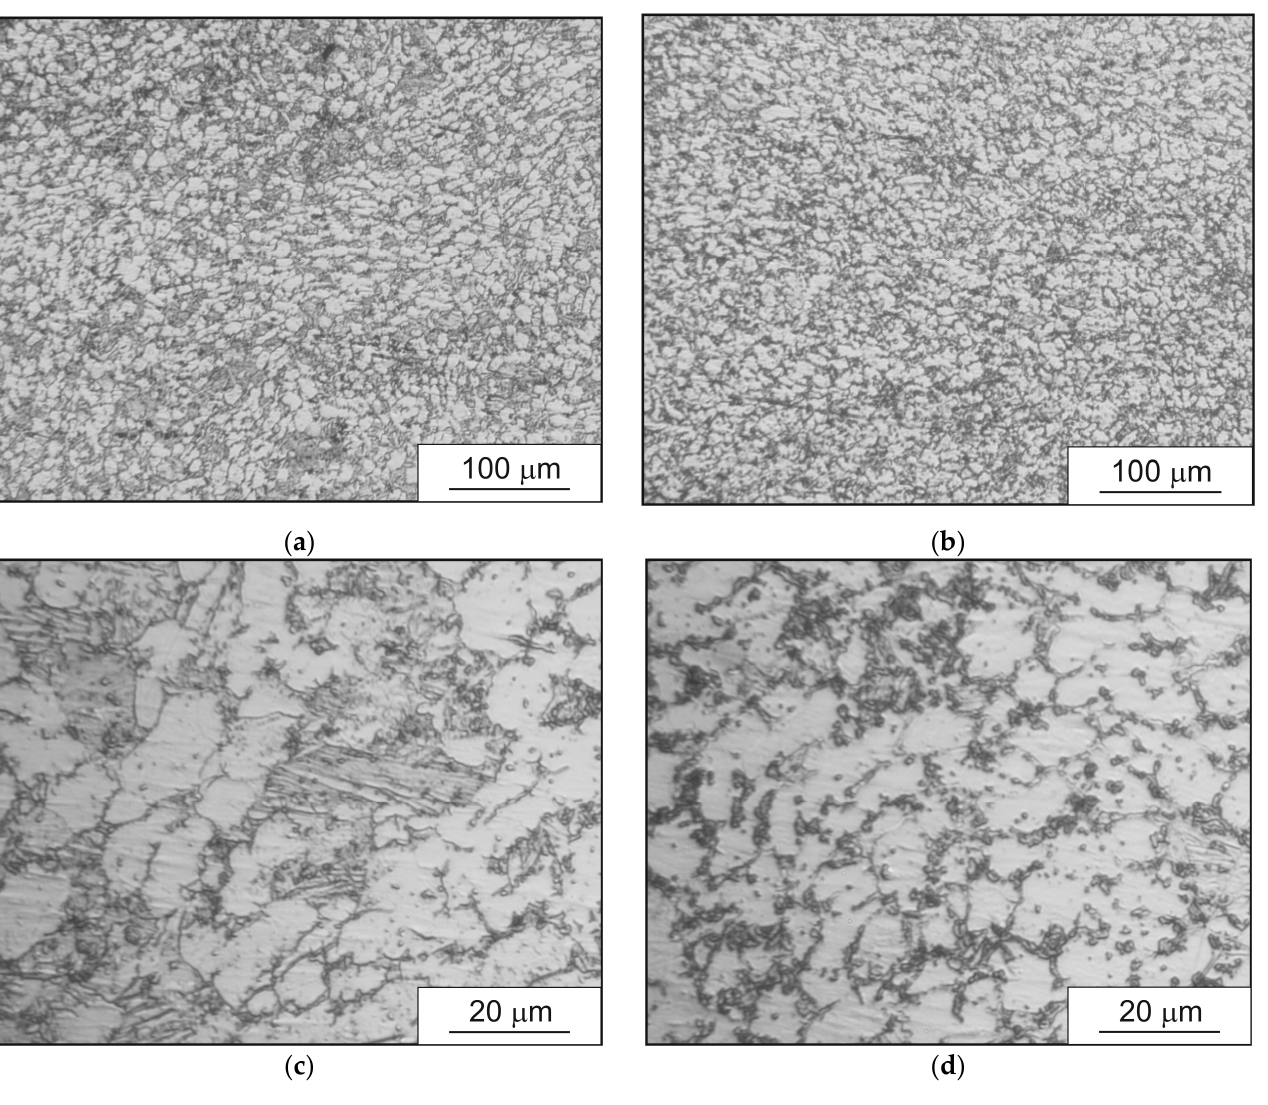
Figure 7. Ti-6Al-4V microstructure in the cross section of the billet: ( a , c )—central region of the billet and ( b , d )—near the surface region.